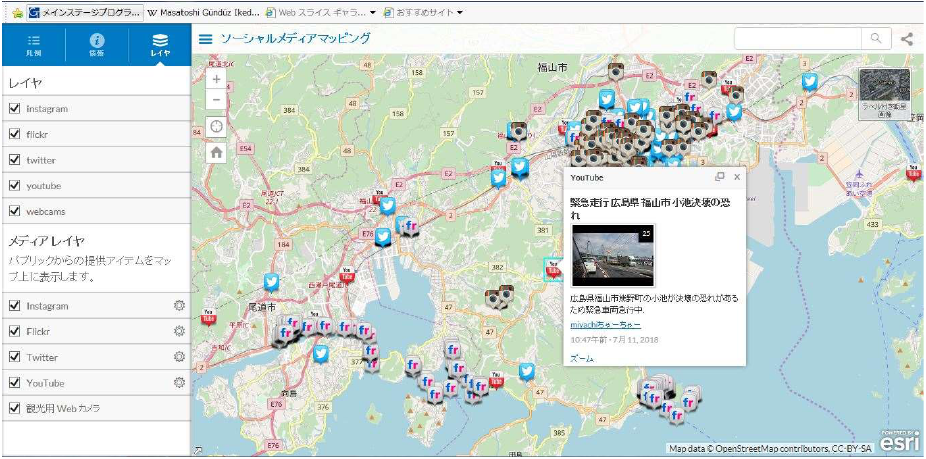
Fig. 5. Information related to the collapsed reservoir in Fukuyama City, Hiroshima Prefecture using YouTube.